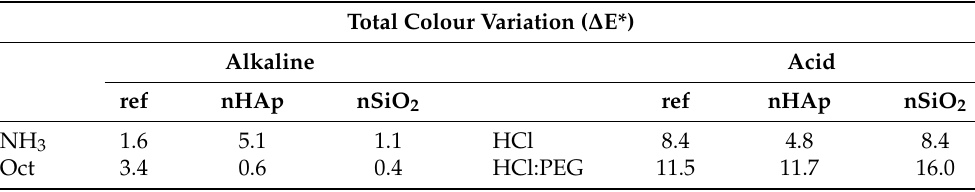
Figure 6. Colour variation of the stone surfaces upon treatment with all prepared formulations: ( a ) a * vs. b * and ( b ) C * vs. L * parameters. Table 5. Overall total colour change ( ∆ E*) after consolidation treatment by comparison with un- treated